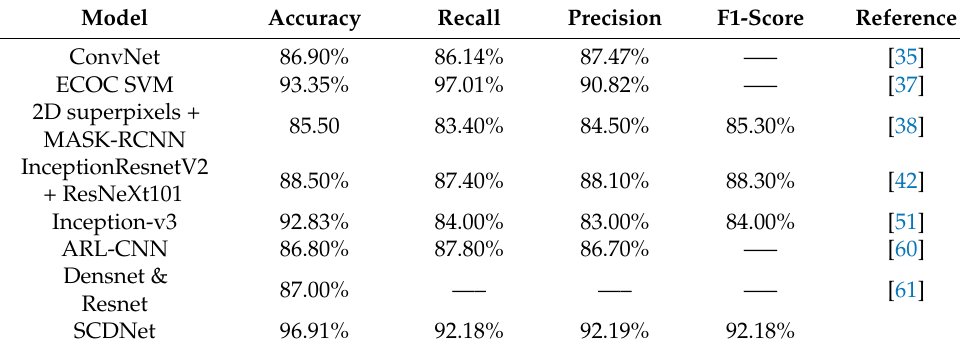
Table 6. Performance comparison of SCDNet with pre-trained